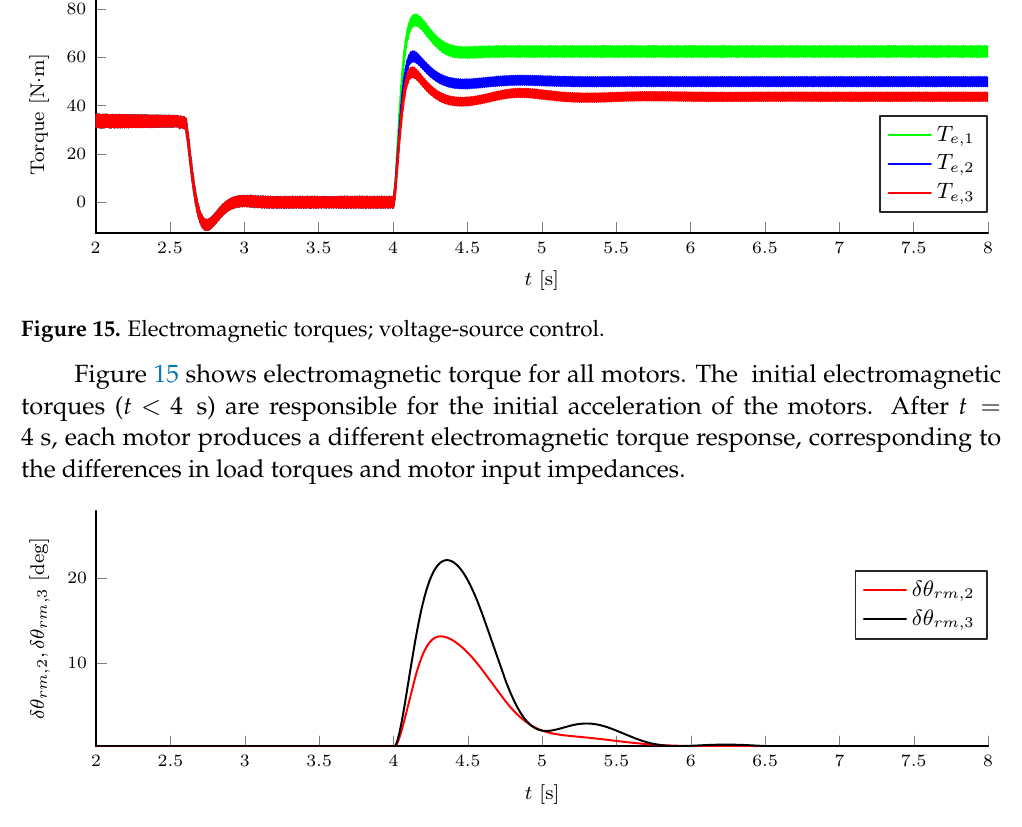
Figure 16. Individual angle differences; voltage-source control.